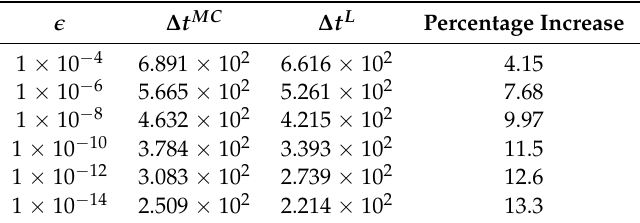
Table 2. Comparison of time-step